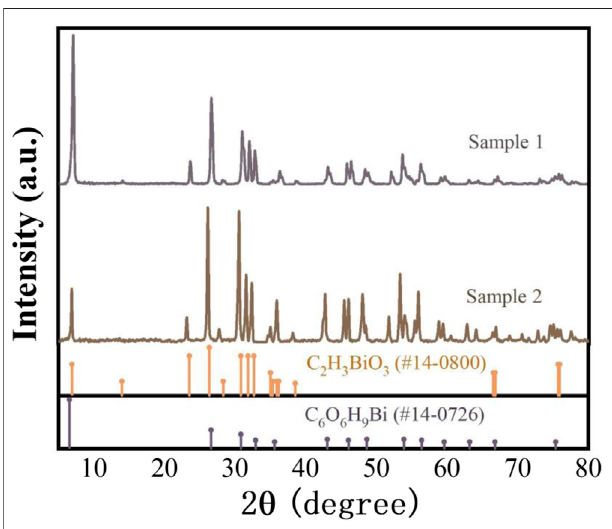
FIGURE 5 | XRD analysis of the incompletely dissolved lead – bismuth alloy